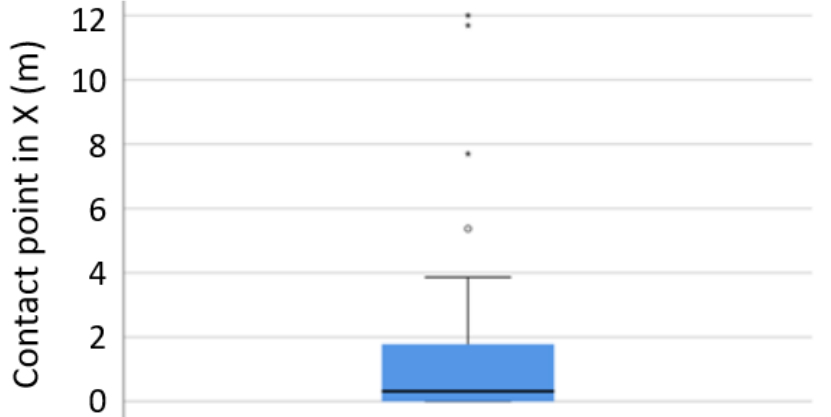
Figure 11. Scenario 2: collision angles between truck and cyclist in right turn crashes, based on GIDAS.